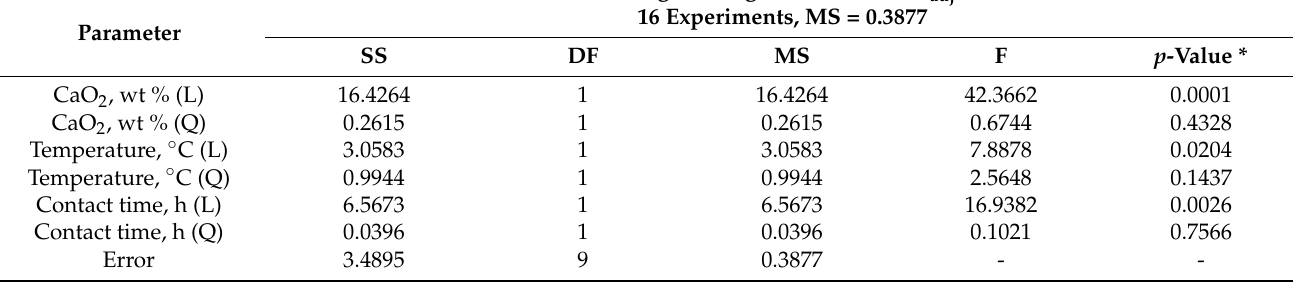
The data presented in Figure 3 indicated the linear relationship between the observed and approximated values of the number of E. coli